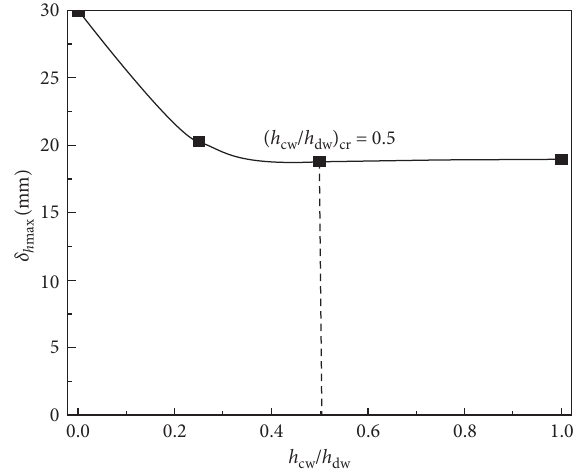
Figure 17: Relationship between δ